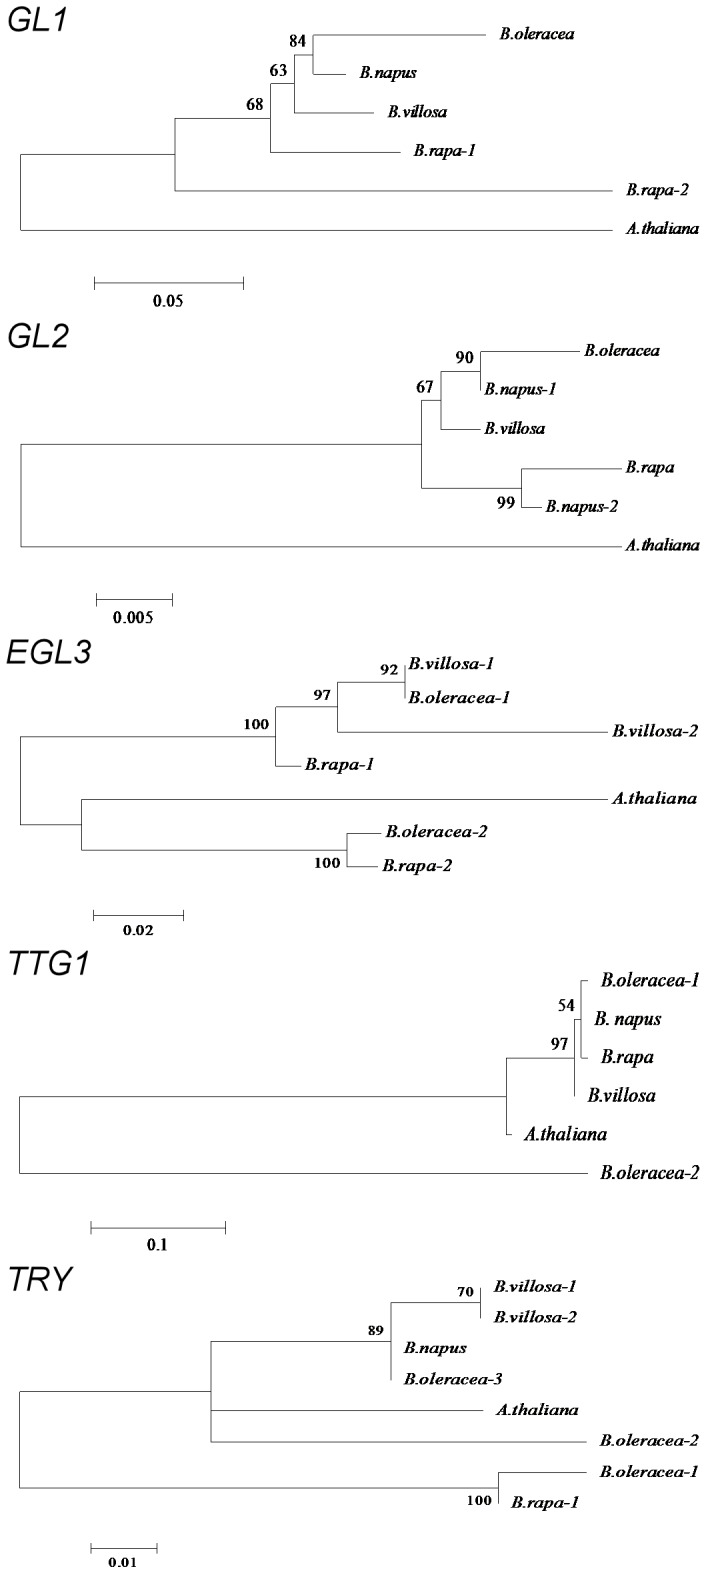
Phylogenetic relationships for the five major trichome regulatory genes present in Brassica and A. thaliana.Sequences were analysed by the maximum likelihood method with bootstrap values (%) indicated (100% is implicit in vacant branching positions). Scale indicates amino acid substitutions per site. A consensus sequence based on six B. napus TTG1 copies in NCBI was used for more robust analysis rather than the individual BnTTG1 copies, which each gave very weak associations due to limited overlapping sequence. B. rapa TRY-2 and TRY-3 were also not included since their small size gave spurious weak associations of <50%. Although three copies for TRY exist in B. oleracea and B. villosa (Fig. 2), TRY-3 could not be cloned from B. villosa cDNA due to low expression.